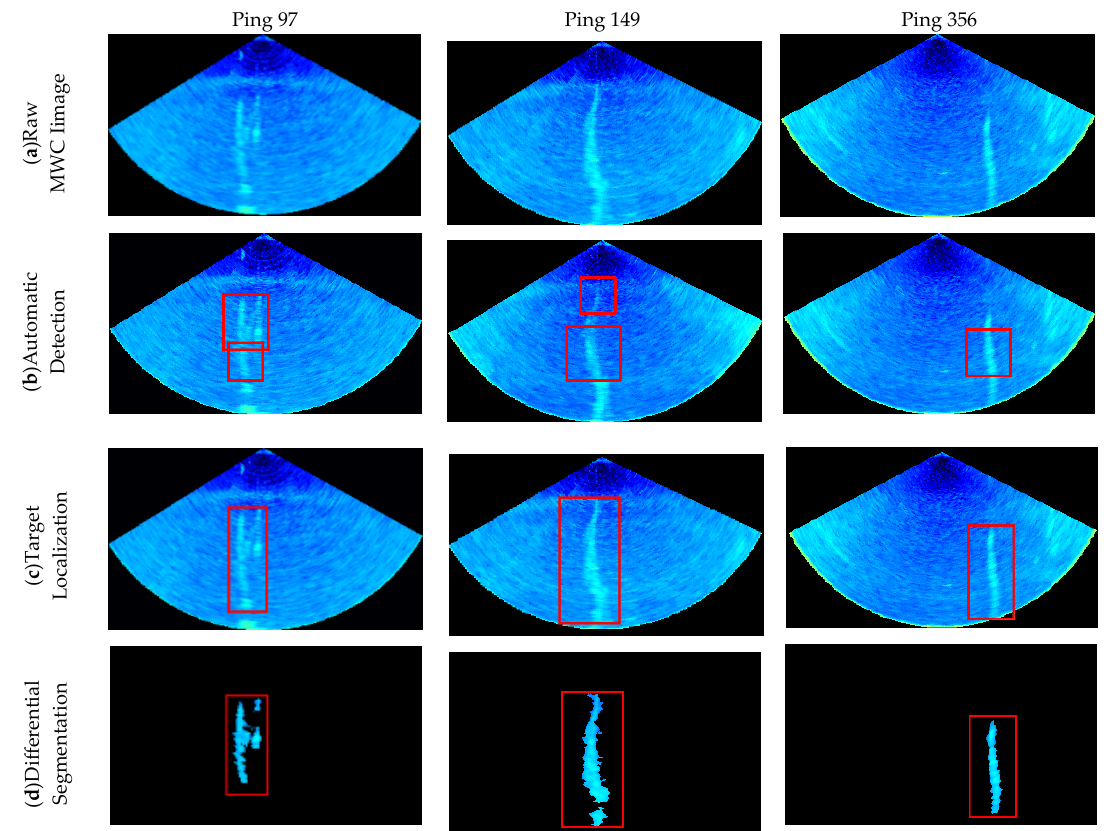
Figure 17. Gas plumes detected and segmented by the proposed method. ( a ) Raw MWC images with Ping No. 97, 149 and 356; ( b ) gas plumes detected by the proposed Haar–LBP detector; ( c ) the target-box localization by the proposed target localization algorithm; ( d ) gas plumes segmented by the proposed differential segmentation algorithm and morphological constraint algorithm.